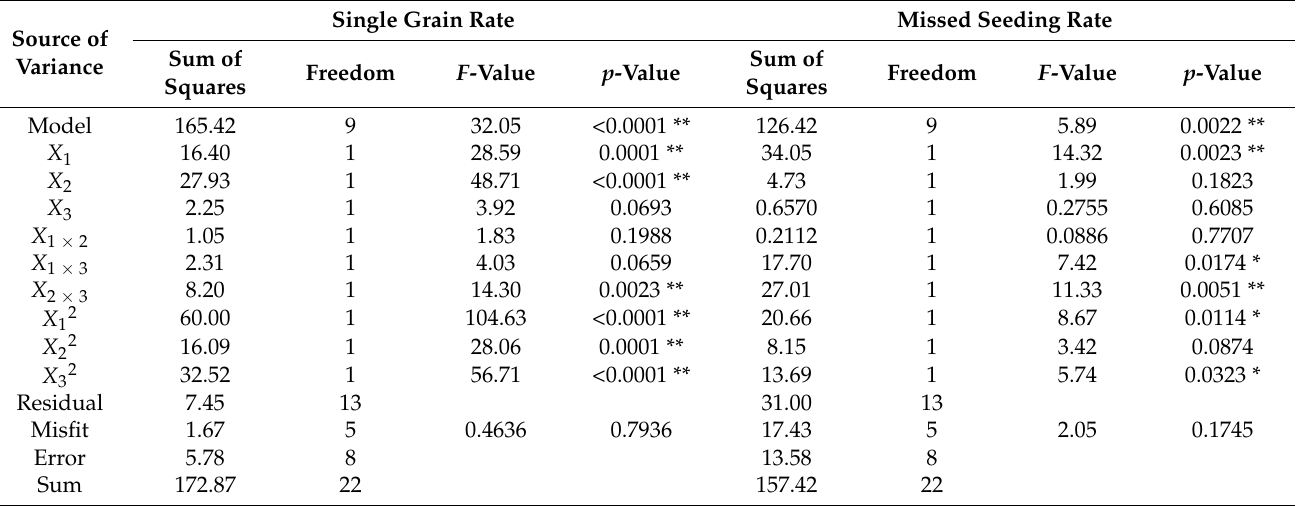
Table 4. Analysis of variance for regression